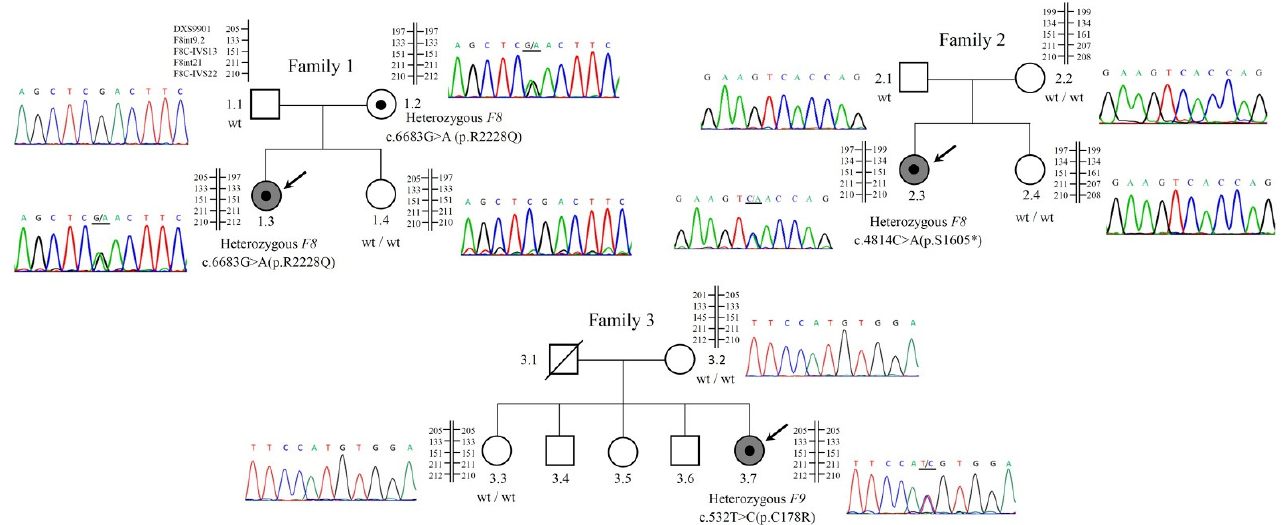
Figure 1. Pedigree information of three families with female hemophilia A (HA) (families 1 and 2) and hemophilia B (HB) (family 3). The female patient of family 1 (case 1.3) carries a heterozygous c.6683G>A(p.R2228Q) mutation in F8 that was inherited from her unaffected mother (case 1.2). The female patients of family 2 (case 2.3) and family 3 (case 3.7) carry heterozygous c.4814C>A(p.S1605*) in F8 and c.532T>C(p.C178R) mutations in F9, respectively; both were of de novo origin. Linkage analysis was performed by using five X-linked short tandem repeat (STR) makers (DXS9901, F8int9.2, F8C-IVS13, F8int21, and F8C-IVS22). Arrow denotes the proband. Underlined nucleotide denotes the position of the mutation. White square and circle symbol denote unaffected males and females, respectively. A white circle symbol with a black dot denote an unaffected female carrying a heterozygous mutation without skewed X-chromosome inactivation (XCI) and a gray circle sym- bol with a black dot denote an affected female carrying a heterozygous mutation with shewed XCI. Slash denotes an individual who is deceased. *, a nonsense mutation that changes an amino acid to a translation termination (stop) codon.